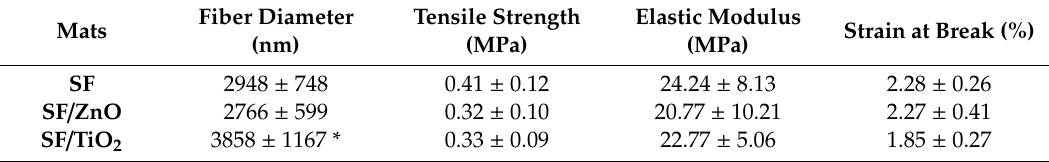
Average values of fiber diameter and mechanical properties studied in SF / ZnO electrospun materials.